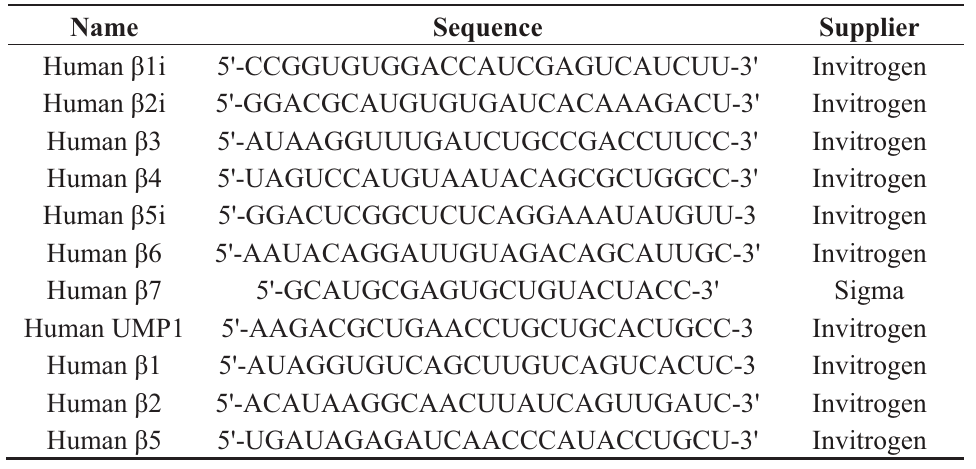
Table 1. siRNA sequences used in the study on the